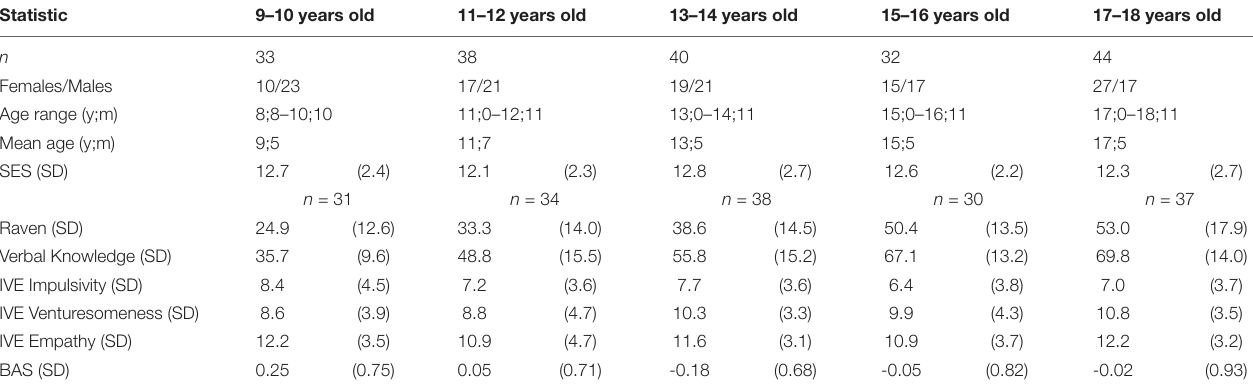
TABLE 1 | Descriptive statistics, control, and self-report measures on impulsivity and approach